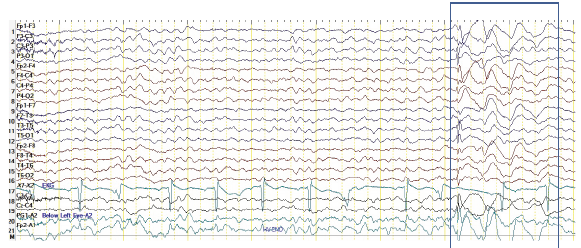
Figure 2: Electroencephalogram (EEG) demonstrating micro- seizures. The EEG was obtained on Day 134 of clozapine therapy [Day 88: clozapine dose escalation to 400mg per day (with concur- rent lithium 450 mg PO BID), Day 109: development of